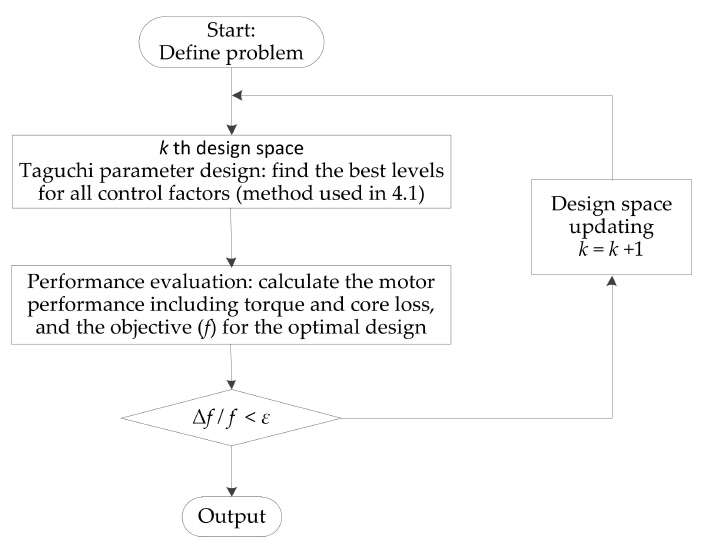
Figure 10. Flowchart of the sequential Taguchi optimization